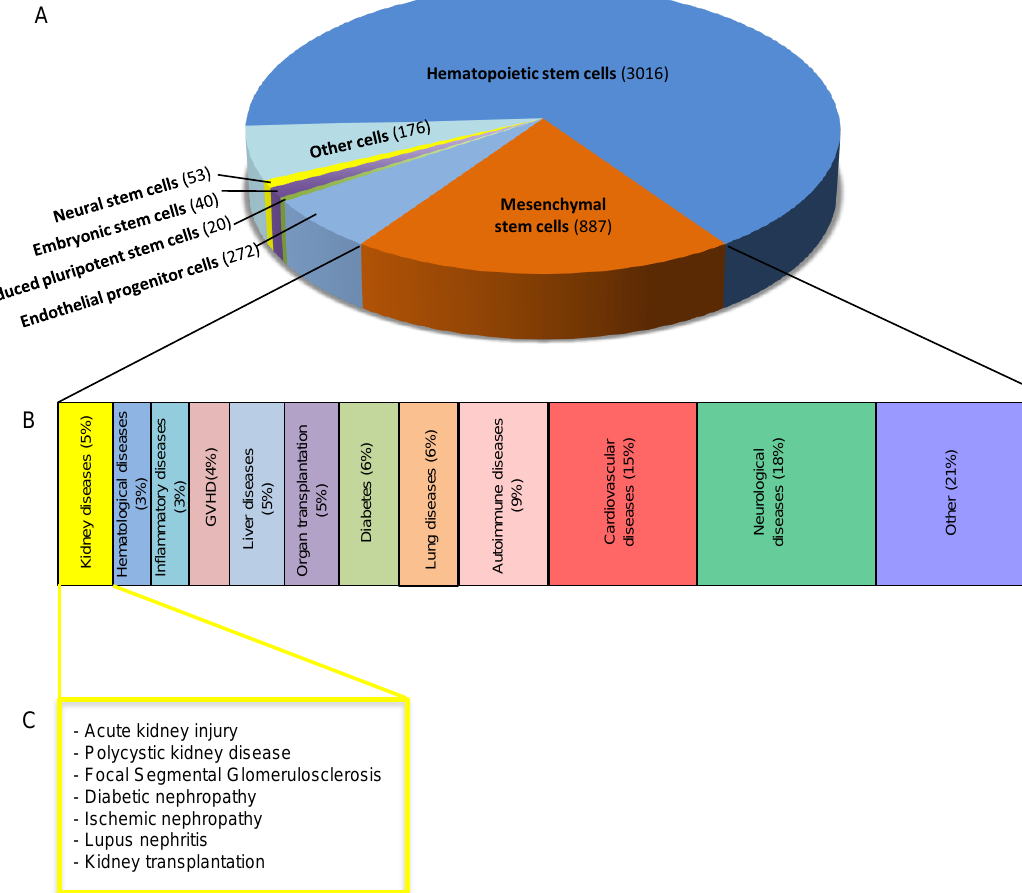
Figure 1. Clinical trials with cell-based therapy: embryonic and adult stem cells. ( A ) Pie chart showing the relative numbers of clinical trials using di ff erent types of stem cells as listed on the U.S. NIH website clinicaltrials.gov. ( B ) Percentage of MSC-based clinical trials classified by disease type. ( C ) MSC-based therapies in di ff erent kidney